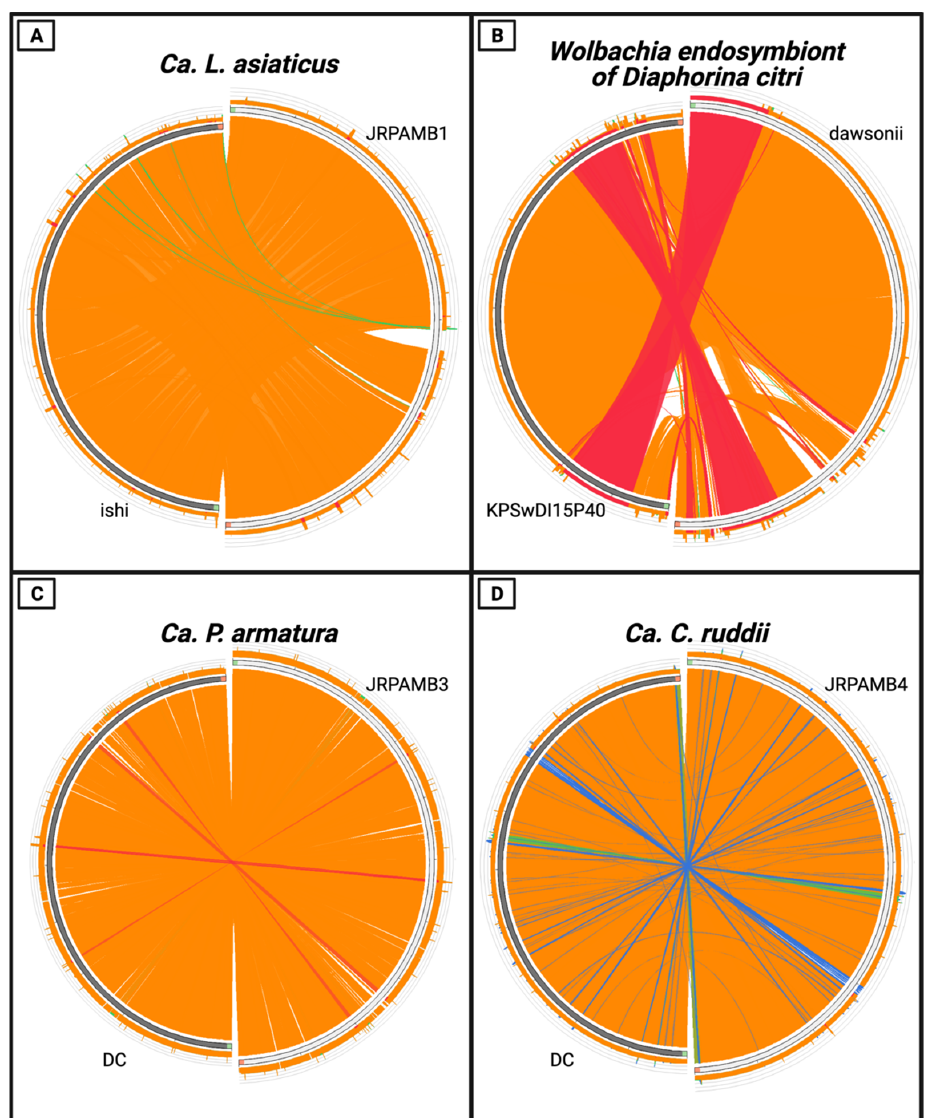
Figure 2. Circoletto plot comparing the nucleotide LCBs of this publication’s strains (right) to the closest relative strains (left) based on the MUMmer ANI across the genome position. The strain on the right of each Circoletto plot was used as the query for the search. An E-value cutoff of 1 × 10 − 40 was used for each construction. The size of each ribbon represents the size of the alignment, whereas the color corresponds to the percent identity of the alignment (red > 99.9999%, orange ≤ 99.9999%, green ≤ 95.9999%, blue ≤ 85.9999%). The absence of a ribbon indicates an area unique to that genome under the search constraints. ( A ) Ca . L. asiaticus str. JRPAMB1 (right) against the nucleotides of str. ishi. ( B ) Wolbachia endosymbiont of D. citri str. dawsonii (right) against the str. KPSwDI15P40. ( C ) Ca . P. armatura str. JRPAMB3 (right) against str. DC. ( D ) Ca . C. ruddii str. JRPAMB4 against str. DC .